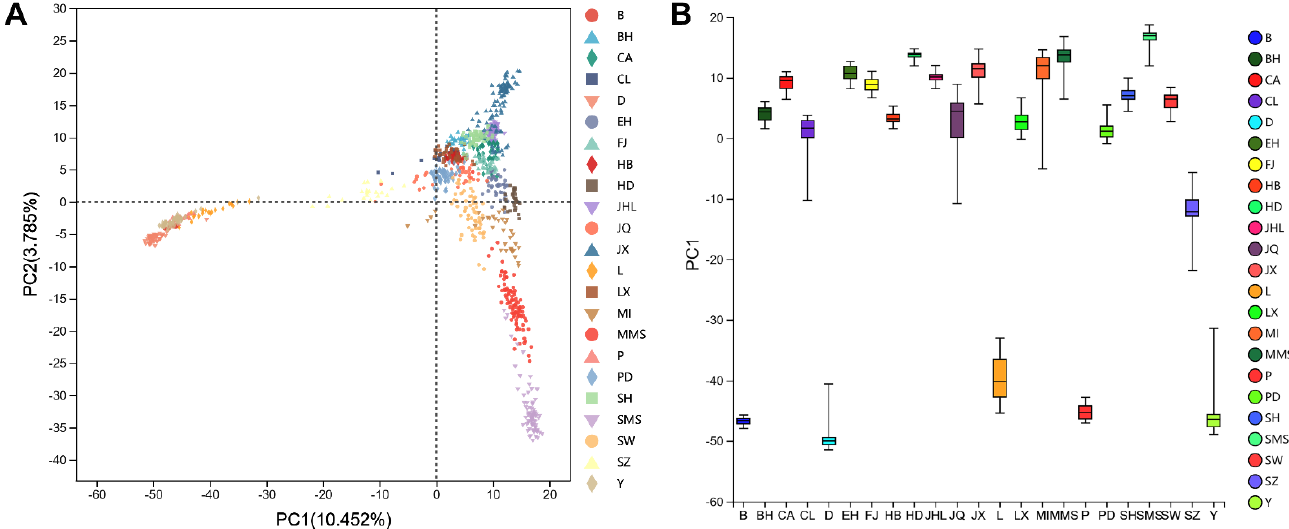
Figure 1. Principal component analysis (PCA) for 23 pig breeds based on 14,823 SNPs. ( A ) Plots of PC1 and PC2; ( B ) PC1 reflects the main difference between the cosmopolitan breeds and Chinese indigenous pig breeds.